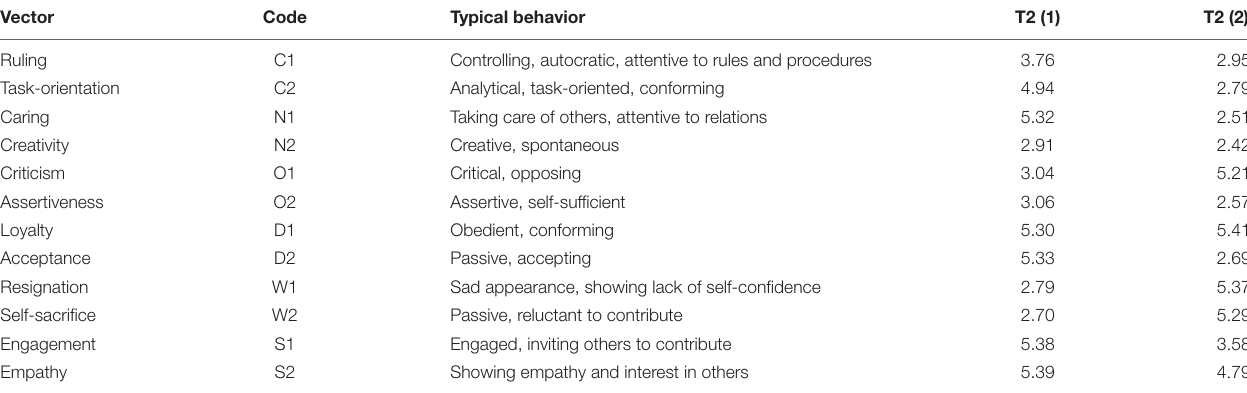
TABLE 5 | Comparison between two municipalities, with implementation (exploratory) and without implementation (control) at T2. Vector Code Typical